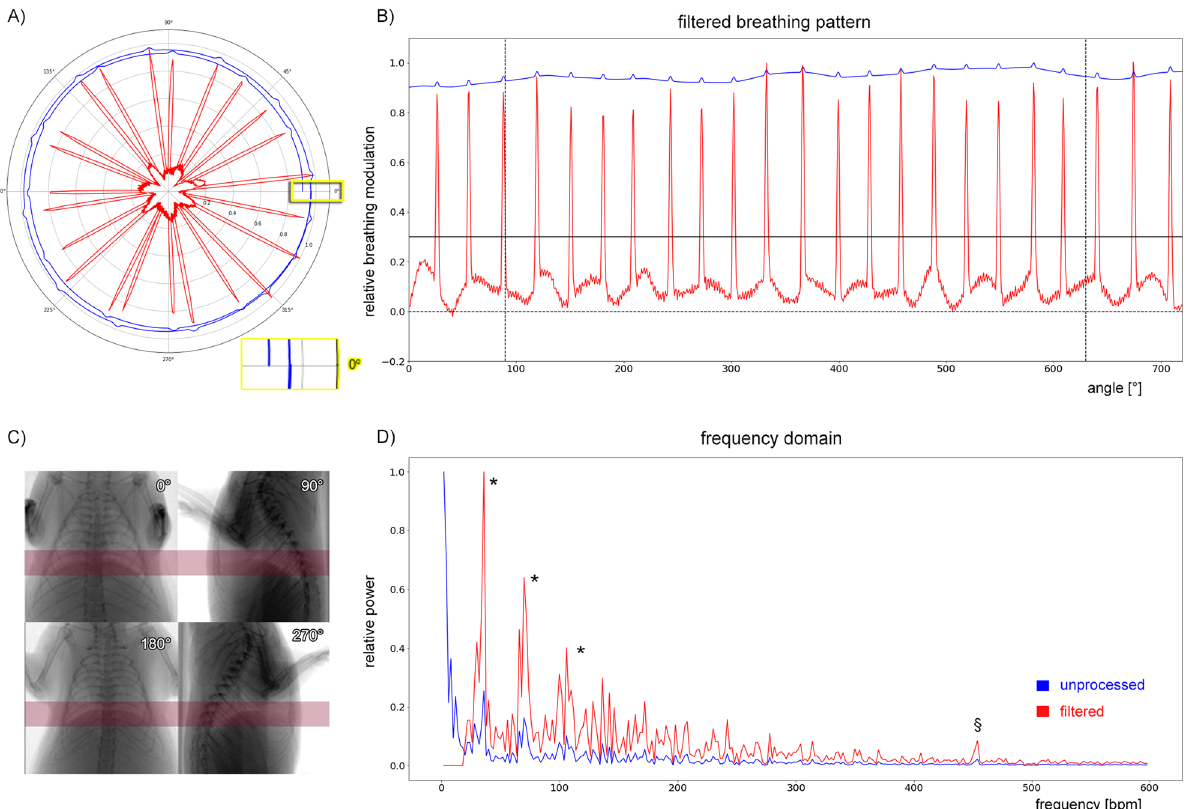
Figure 1. Principle of retrieving the breathing motion from the set of angular distributed projection images. ( A ) Polar plot of the average X-ray transmission over a region of interest (ROI) covering the entire cross-section of the mouse at the lung-diaphragm interface (blue) is shown. The breathing is only visible as subtle modulation of the signal and therefore a background correction is need, which is hindered by the fact that the signal is not strictly 2 pi periodic (insert). ( B ) The final breathing pattern after background correction is shown in red. To suppress potential imprecision in the background correction and the beginning and end of the acquisition a ◦ range of 90 from the start and end of the measurement (vertical dashed lines) was discarded. The amplitude of the remaining angular range was normalized to [0,1]. A level of 0.3 (horizontal dashed line) was used to identify breathing events in the resulting function. ( C ) Representative projection images are shown at 0, 90, 180 and ◦ 270 with the ROI indicated in red. ( D ) Comparison of the power spectra of the unprocessed data (blue) and the processed data (red) shows that after background removal the breathing events and their harmonics can clearly be seen (* asterisks). Moreover, the frequency of the heart beat can be detected as well (§). The figure was generated using matplotlib 3.5.1 www. matpl otlib. org and gimp 2.10.28 www. gimp. org.